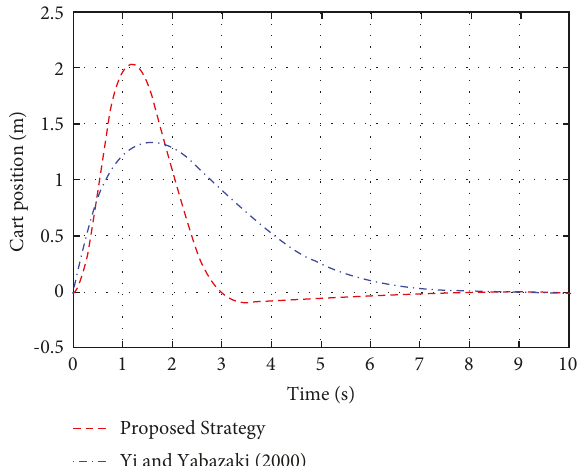
Figure 10: Cart position based on the suggested fuzzy-PID controller and Yi and Yabazaki’s technique with initial condition [ 0 , 0 , 0 , 0 , π /6 , 0 ] .